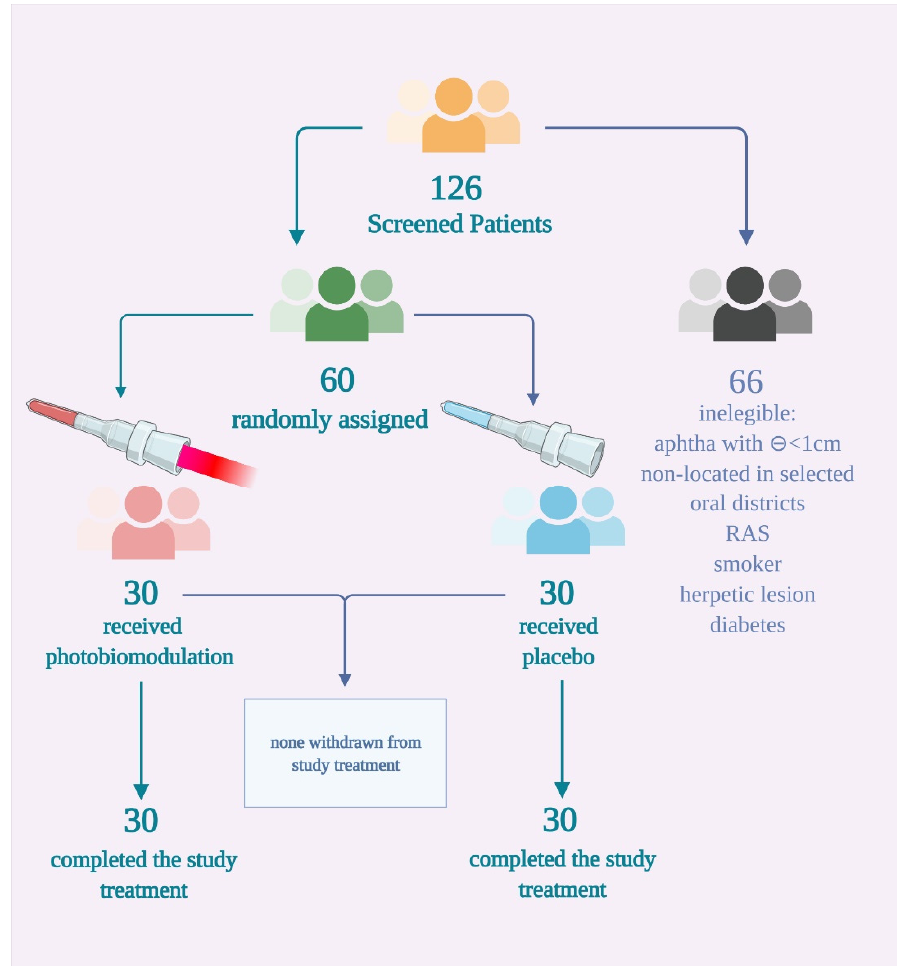
Figure 2. Design of the participants’ randomization. Image created with BioRender.com. (accessed on 1 April 2021).